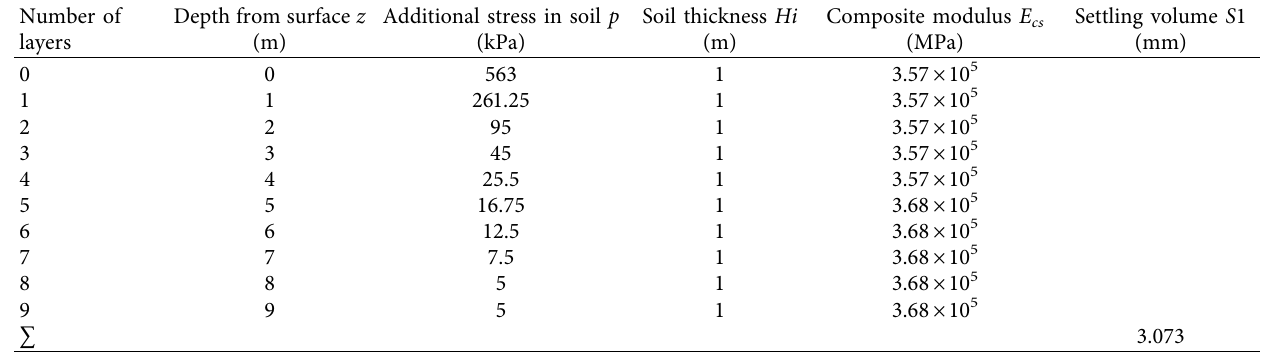
Table 5: Summary of calculation